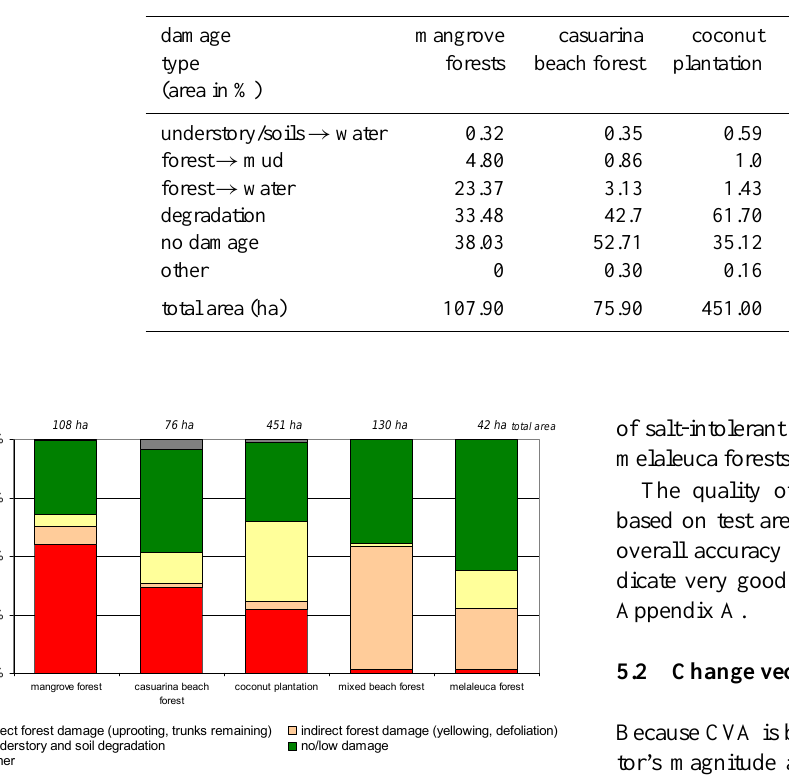
Fig. 8. Damage patterns based on direct-multi-date classification.